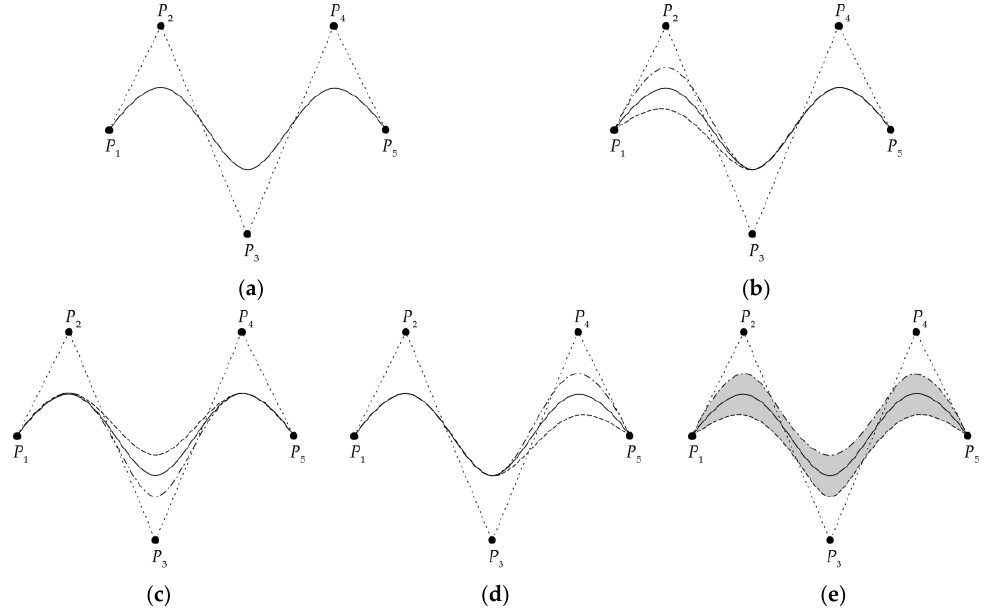
Figure 2. The relationship between local shapes and three shape parameters of the GE-Bézier curve with five invariant control points ( P 1 , ... , P 5 ): ( a ) The curve with three appropriate waves when the shape parameters were all median values; ( b ) The first wave changed with the alteration of first shape parameter; ( c ) The second wave fluctuated if only the second shape parameter was changed; ( d ) The third wave varied with the third shape parameter; ( e ) The grey area represents the range of curve shapes within the values of shape parameter ranges.